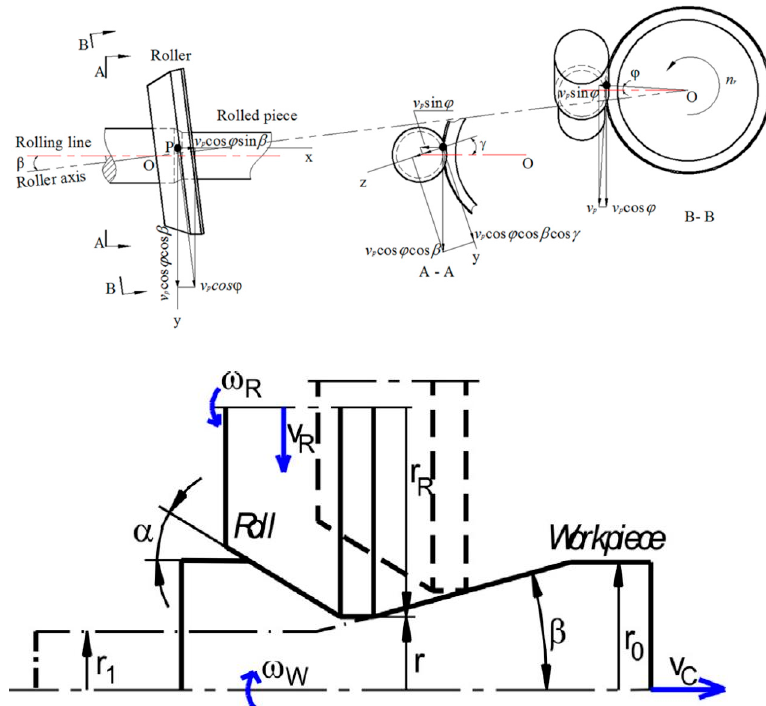
is the angle between the z-axis and the main rolling plane, and j is the angle between the line connecting the P point and the roller axis (the roller radius passing the P point) and the main plane of the roller.